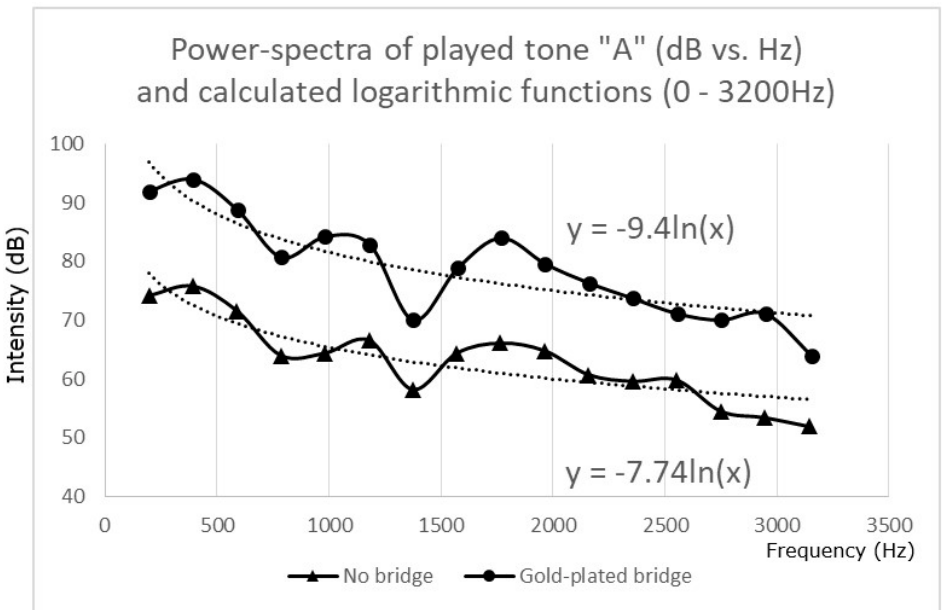
Figure 3. Intensity maxima (dB) of the power spectra of played tone A (base frequency, 196 Hz) with a mounted bridge or without bridge and respective calculated logarithmic functions of the displayed data in the range of 196–9000 Hz (see Material and Methods). Intensity values with the mounted bridge are shifted by +20 dB on the y -axis, for better visibility of the data. As such, the upper displayed function represents the data with a mounted bridge.